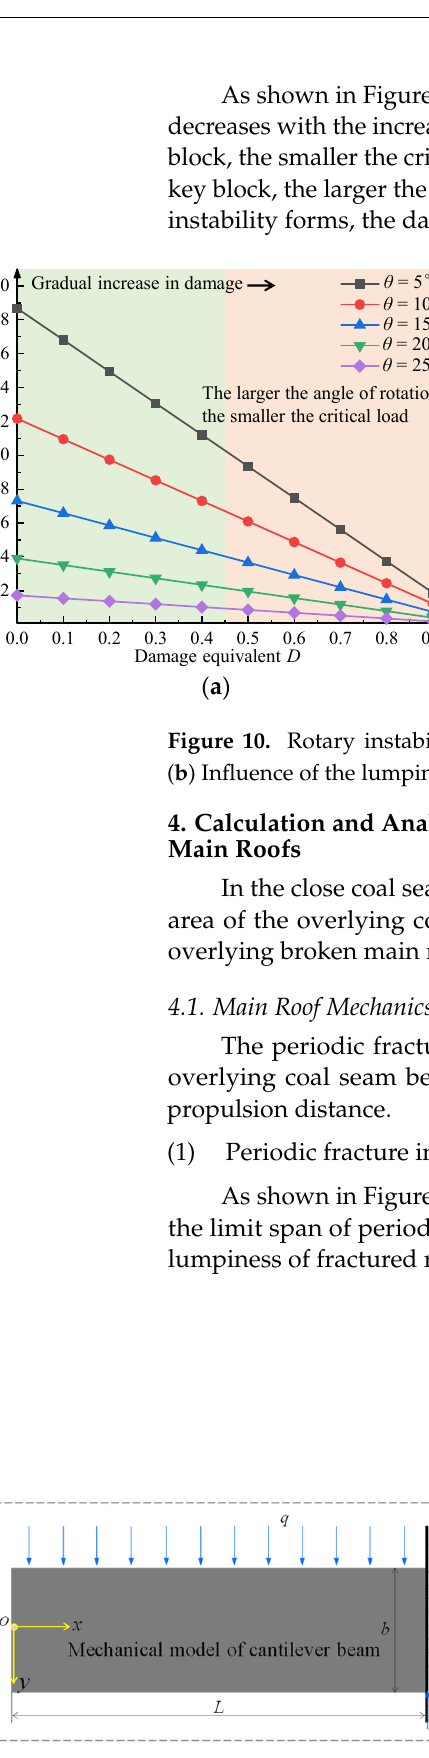
Figure 11. Critical load of rotary instability of the damaged key block.